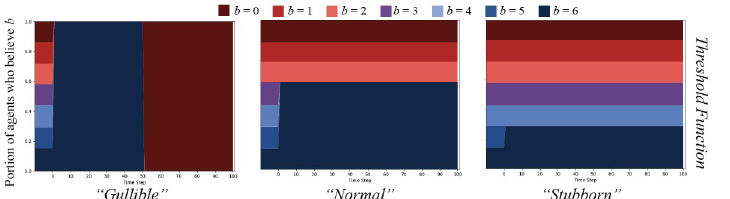
Fig 5. Threshold cognitive contagion function result comparisons. The split message set on an ER random graph, N = 250, ρ = 0.05, for agents updating their beliefs based on the threshold cognitive contagion function in Eq (4). Graphs display percent of agents who believe B with strength b over time. The left graph shows agents parameterized to be “gullible” ( γ = 6); the middle shows “normal” agents ( γ = 3); and the right, “stubborn” agents ( γ = 1).